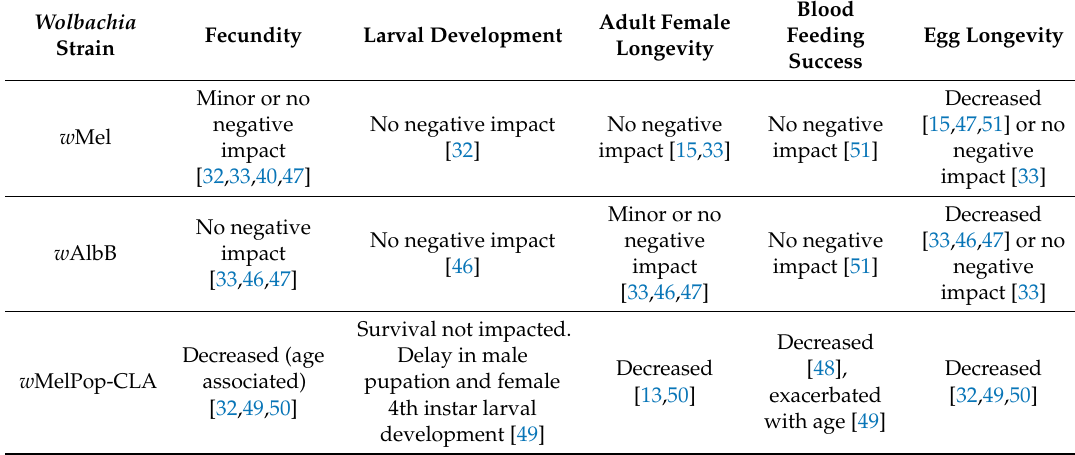
Table 1. Fitness impacts of w Mel, w AlbB and w MelPop-CLA on Aedes aegypti fitness, relative to Wolbachia -free Aedes